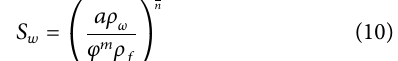
Frontiers in Earth Science |